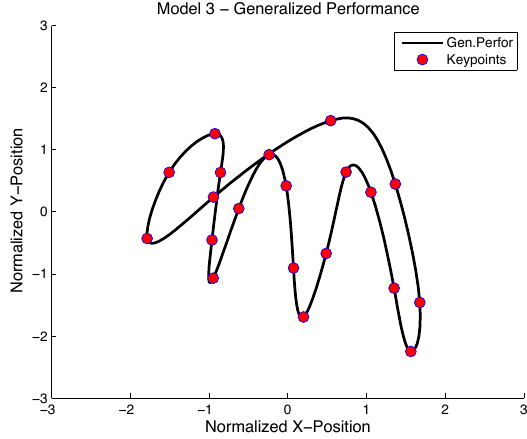
Figure 8. Spline Regression: knots are set at the calculated time vector. The DTW key points are the values from the warped basic gestures at this time vector. The knots and the DTW key points are input to cubic spline regression. The example shown here is for the y-coordinate and is for the generalised trajectory of subject 1 - model 3.